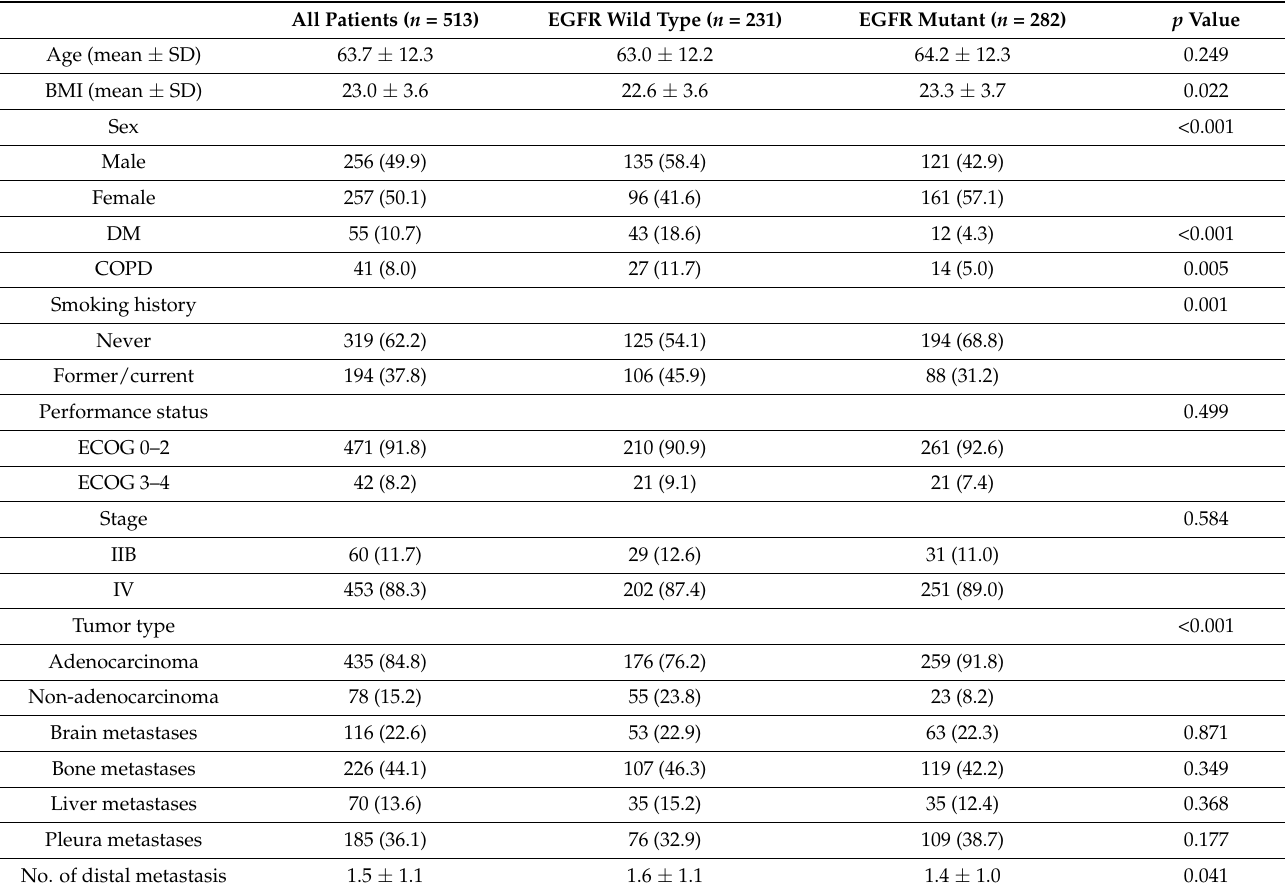
Table 1. Clinical characteristics of study patients ( n = 513).